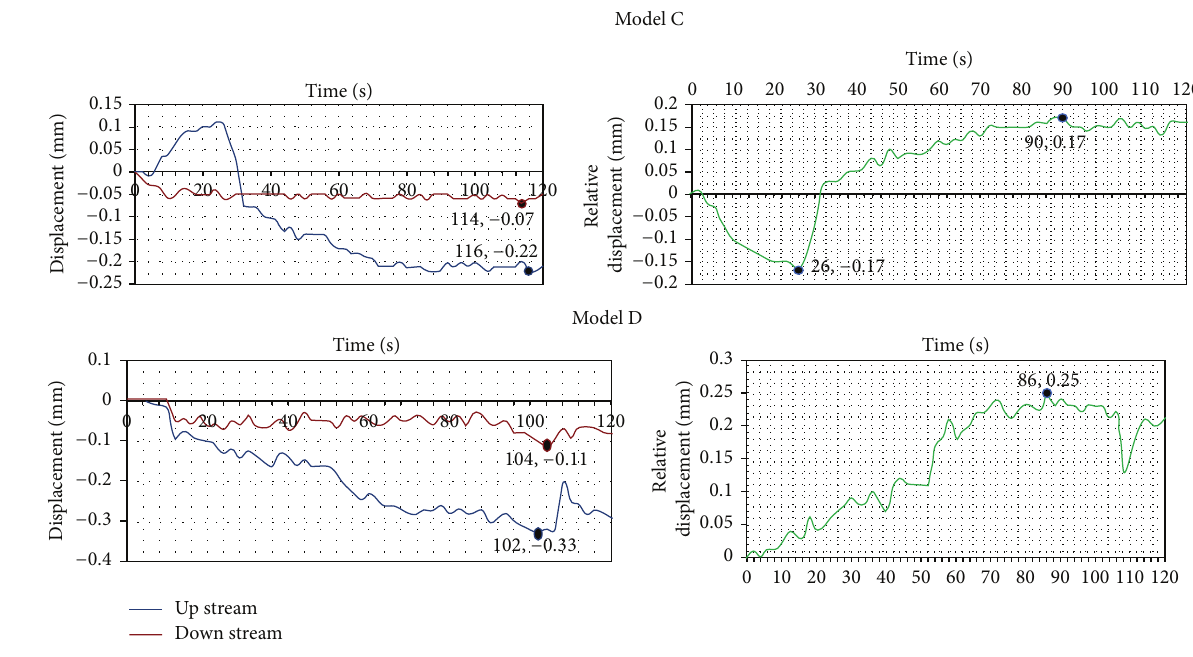
Figure 19: Vertical displacement in both edges of the crest in models with relative